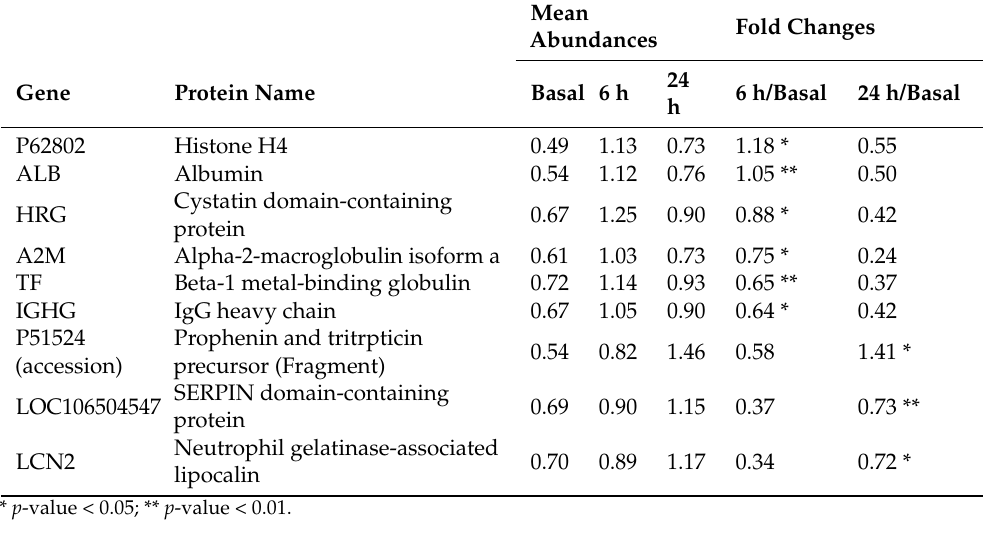
Table 3. Differentially expressed salivary proteins in pigs with experimentally-induced non- septic inflammation.